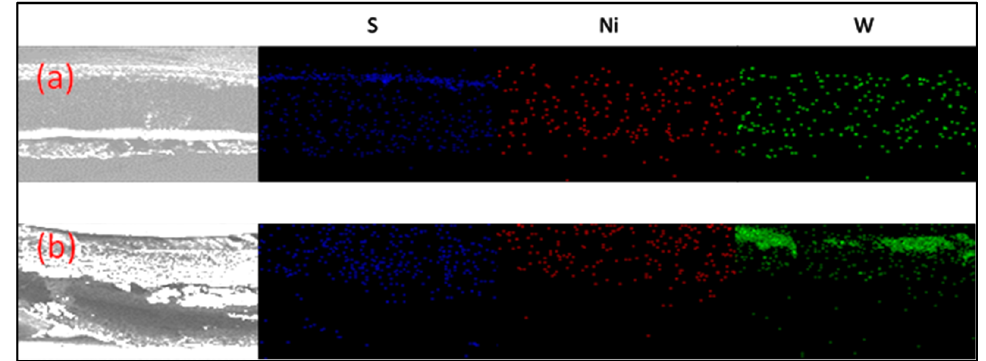
Figure 8. SEM and EDX mapping for S, Ni, and W of the SPNWL, Ni/W = 1:1 batteries ( a ) before cycling; ( b ) after 100 cycles at 2C.